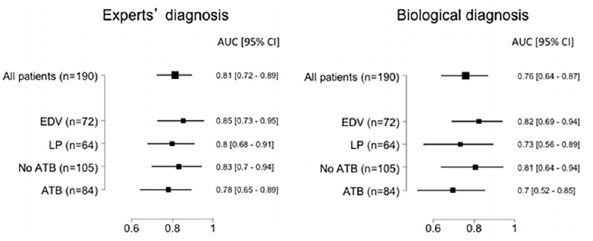
Fig 3. Performance of ROS measurements. The performance of ROS measurements (basal state) in the total cohort of 190 patients according to sampling by LP or EVD, the presence or absence of previous antibiotic administration and a diagnosis of meningitis by the experts or biological criteria (i.e., CSF cells > 100/mm 3 and positive microbiological results